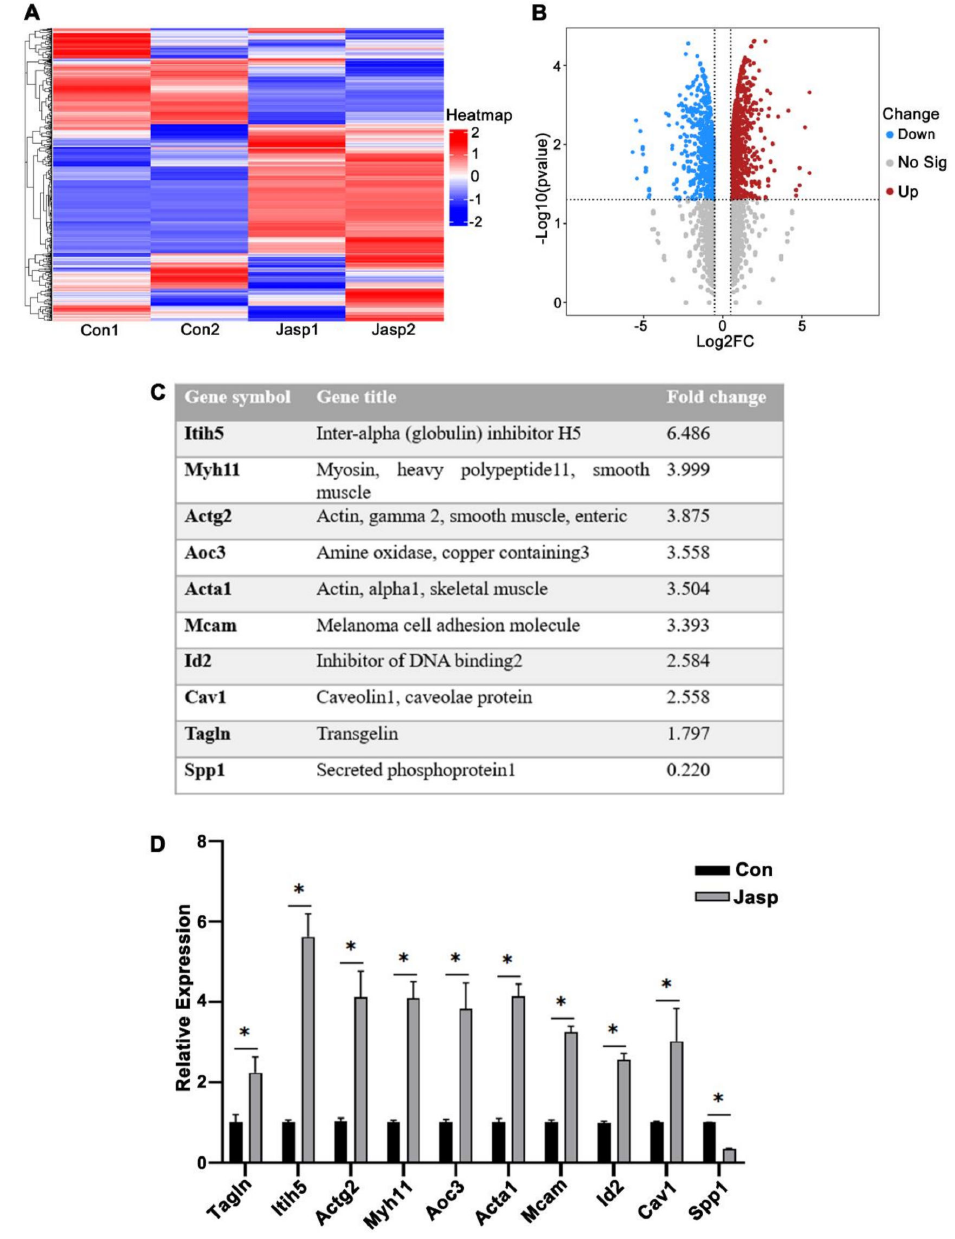
Figure 5. Differentially expressed genes after Jasp treatment of SMCs. ( A ) RNA − seq analysis of mice uterine SMCs on day 3 of pregnancy treated with 100 nM Jasp for 24 h. ( B ) The volcano map showed differentially expressed genes in con and Jasp groups, upregulated genes (red dot), and down-regulated genes (blue dot). ( C ) Molecules associated with actin assembly in sequencing results. ( D ) Verify the mRNA expression level of the changing molecule. * p